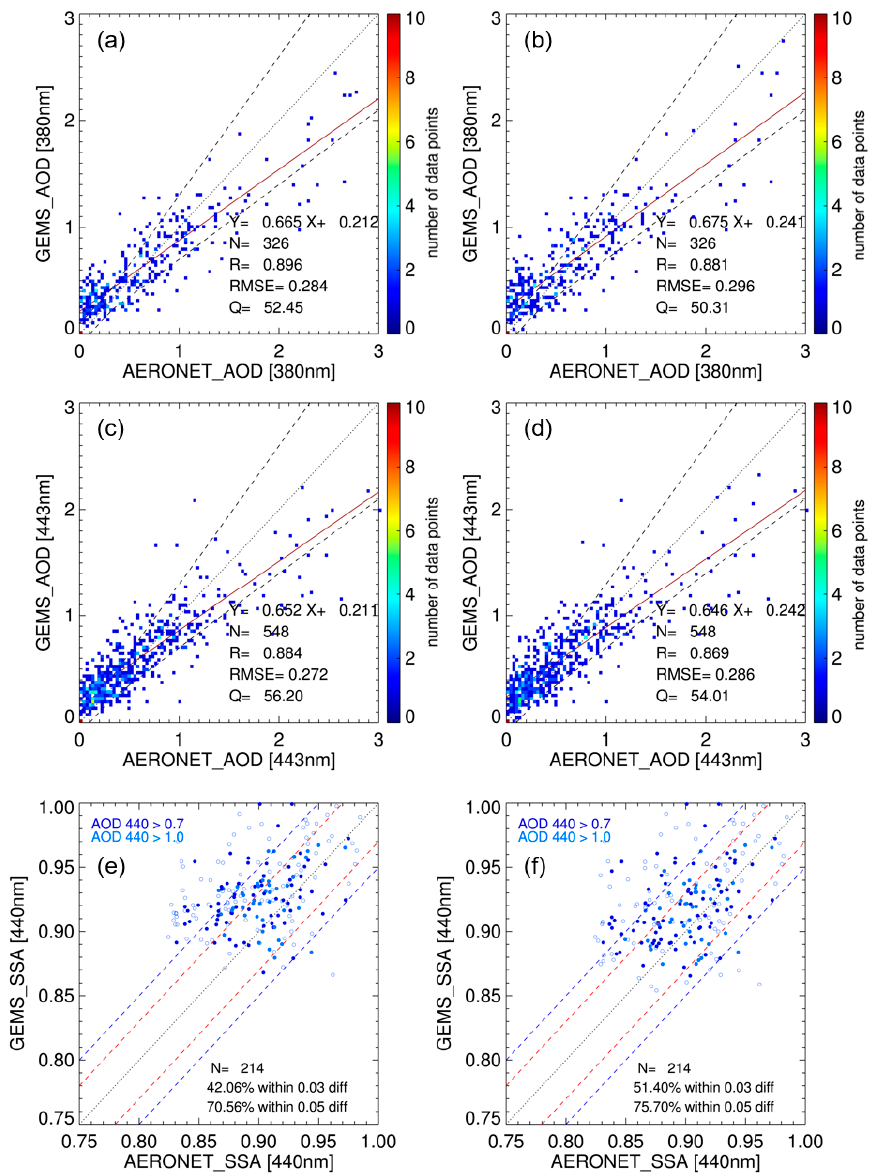
Figure 7. Validation results for GEMS AOD and comparison of GEMS SSA before ( a , c , e ) and after ( b , d , f ) applying TDCI. The 380 nm GEMS AOD values are extrapolated from 443 nm GEMS AOD with an absorption Ångström exponent (AAE) value of the selected aerosol type. In ( a – d ), dotted and dashed lines indicate 1:1 and expected error of AOD (30% or 0.1; Ahn et al. [65]) lines. The red solid line is the linear fitting line for AOD validation results. The corresponding slope ( 𝐴 ) and offset ( 𝐵 ) for the red line are presented in each figure in 𝑦 = 𝐴𝑥 + 𝐵 format. In ( e , f ), the dotted line is the 1:1 line. The red dashed line indicates the theoretical uncertainty ±0.03 of AERONET SSA at 440 nm [51]; the blue dashed line indicates ±0.05 uncertainty, which could be the actual error of AERONET SSA [32]. Results of bias analyses for retrieved ALH data are shown in Figure 8 before (a,c,e) and after (b,d,f) application of the TDCI. As mentioned in Section 2.3, the 1064 nm total attenuated backscatter ( 𝑘𝑚 (cid:2879)(cid:2869) 𝑠𝑟 (cid:2879)(cid:2869) ) from version 4.2.0 Standard product (CAL_LID_L2_05kmAPro-Standard-V4-20) was used to calculate CALIOP ALH. To exclude the presence of clouds and effects of noise, average